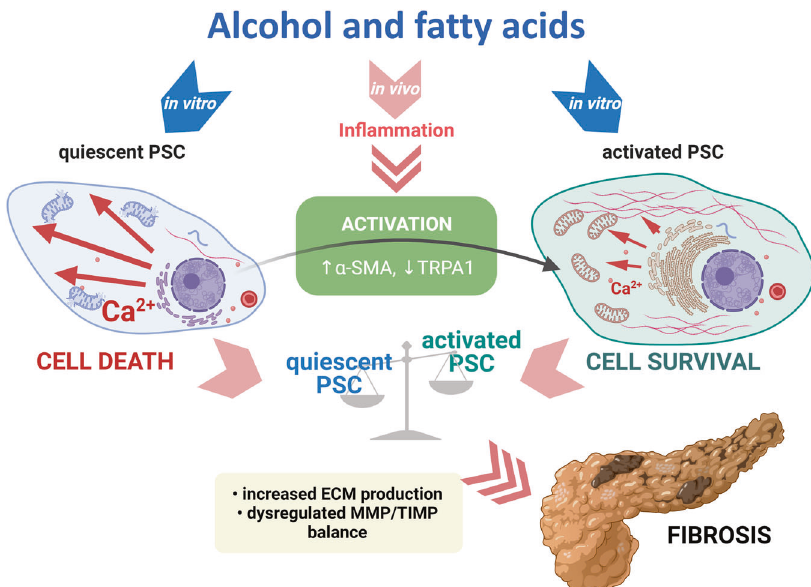
Fig. 7 Schematic illustration of PSC activation and its consequences for alcohol metabolite-induced pathology of the pancreas. Full description in the text (created with